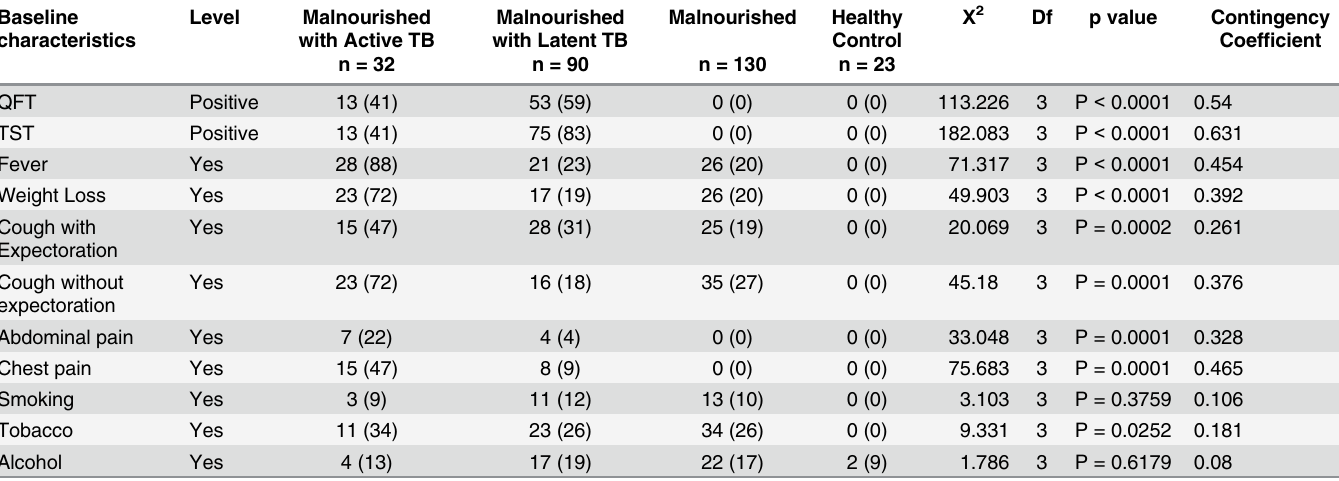
Table 3. Baseline characteristics of population under study.